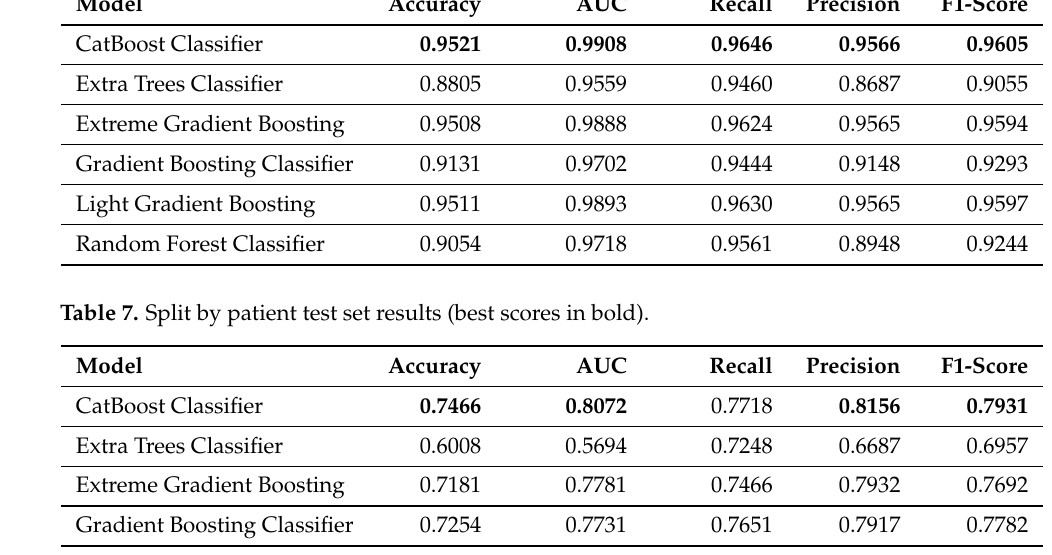
Table 6. Split by patient training set results (best scores in bold). Model